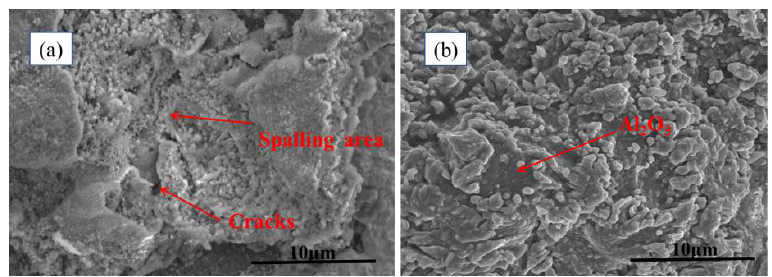
Figure 3. SEM images of sample surface after static oxidation at 1100 °C for 200 h: ( a ) bare substrate; ( b ) coated substrate.